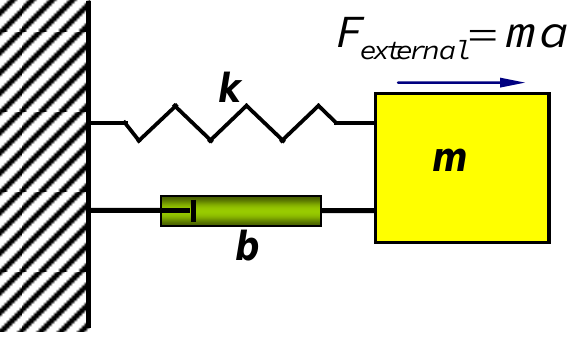
Figure 4. A second-order mass-spring-damper system representing a cantilever based